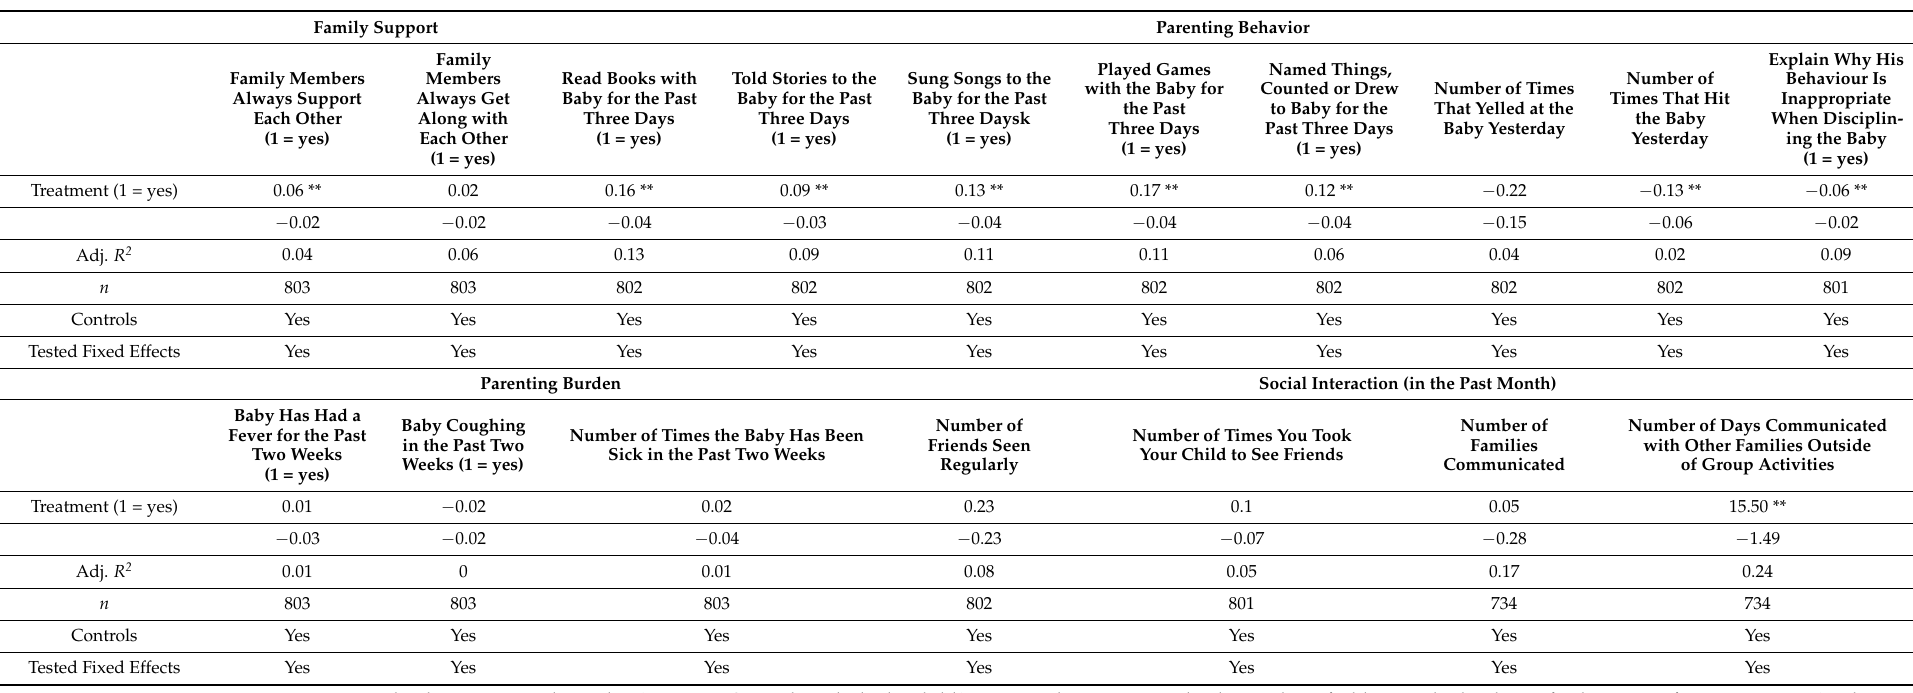
Table 9. Mechanisms of the impact of the intervention on the mental health of female